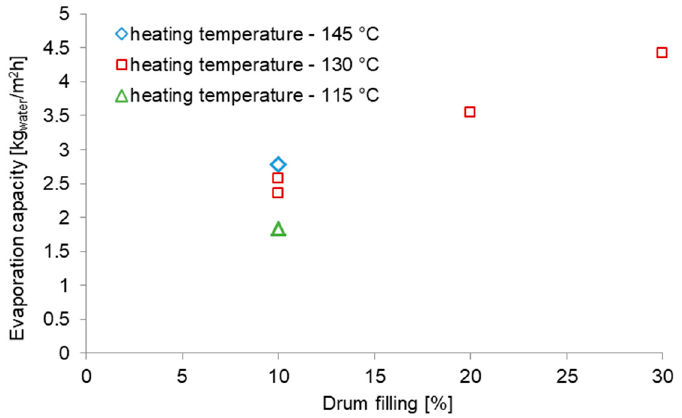
Figure 4. Dependence of evaporation capacity for drying between 50 and 30 wt % on the heating temperature and dryer filling ratio.